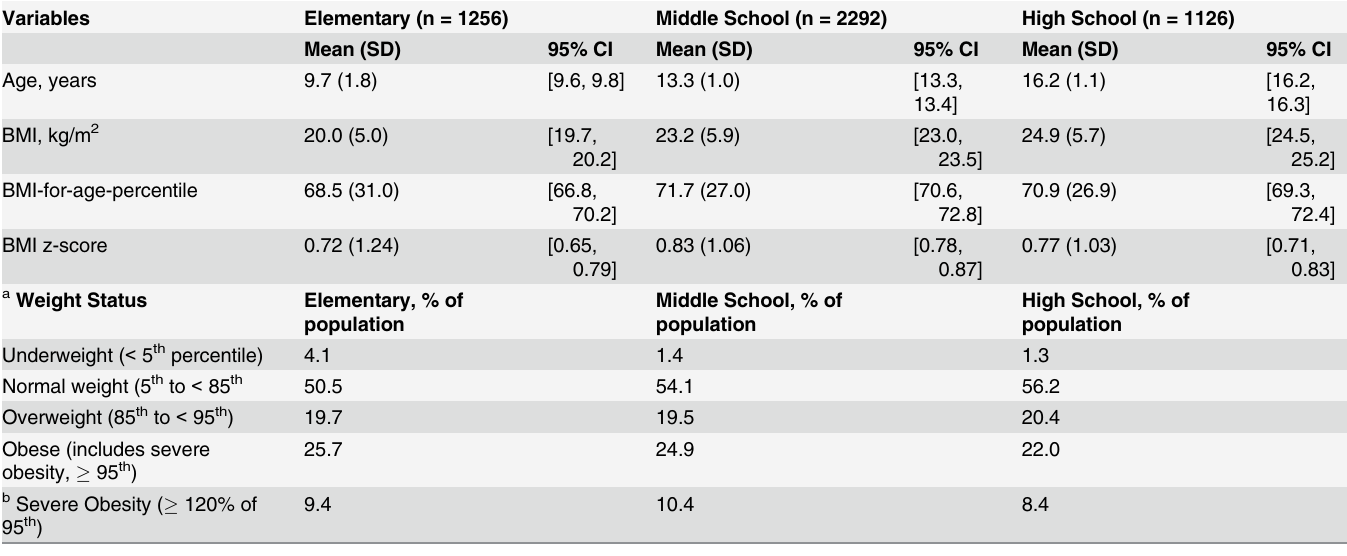
Table 1. Body Mass Index and Weight Status of Urban School Students by Grade